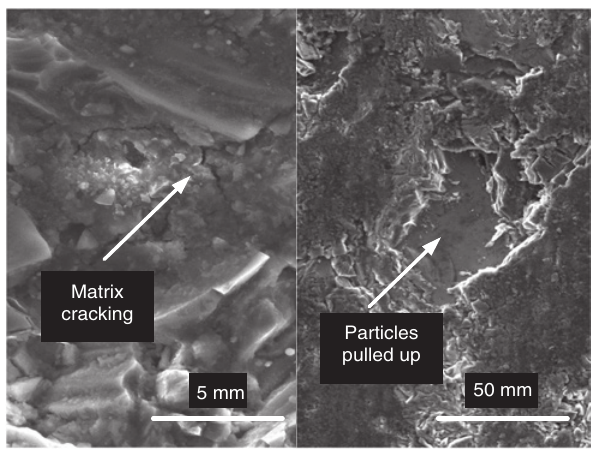
Figure 4: Aluminum matrix cracking and Silicon carbide particles pulled up.